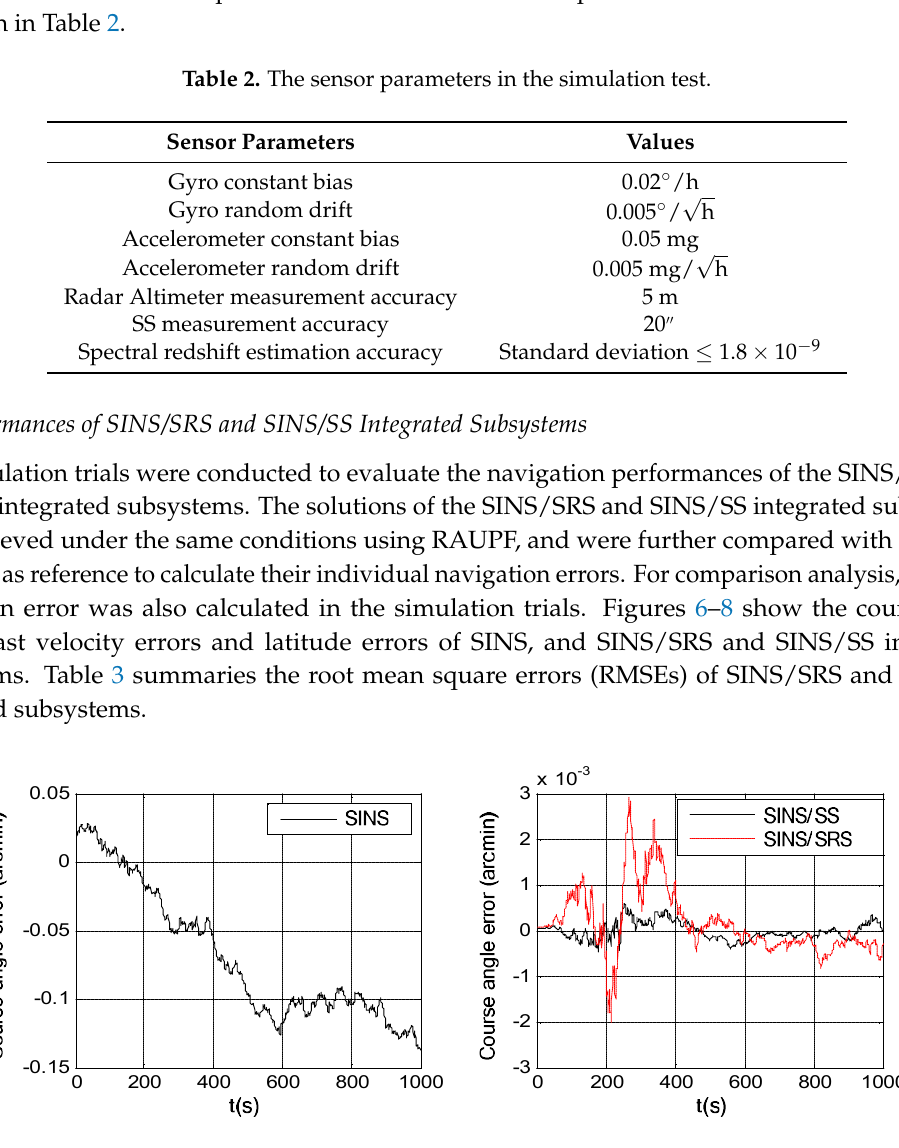
Figure 7. East velocity errors of SINS as well as SINS/SS and SINS/SRS integrated subsystems. 0